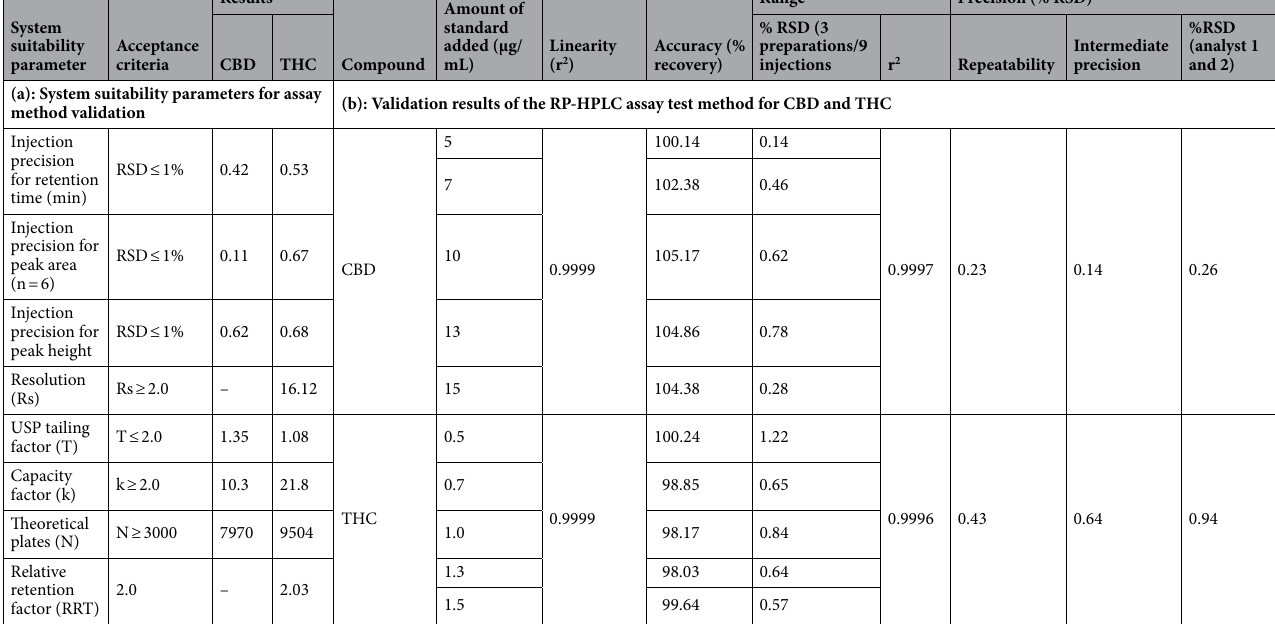
Table 2. System suitability and Validation